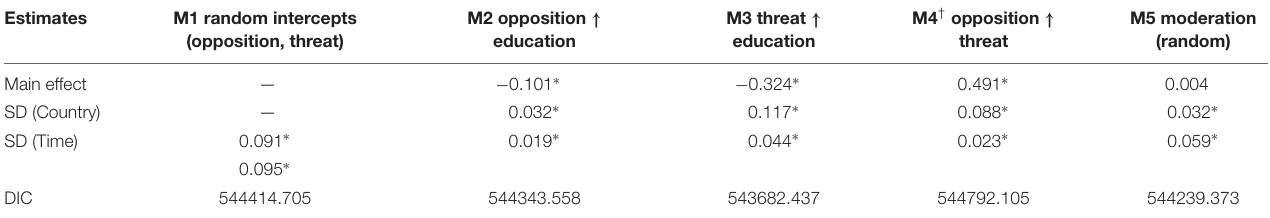
TABLE 6 | Decomposition of random effects between countries and time points. Estimates M1 random intercepts (opposition,